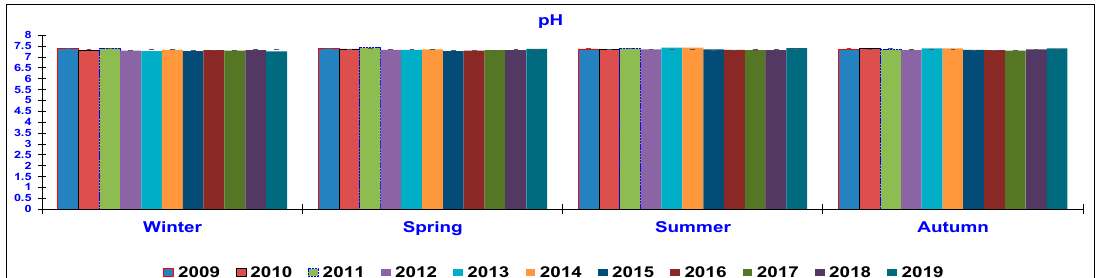
Figure 8. Trend of outlet water Total Phosphorus (TP) (mg/L) (mean ± standard deviation) seasonally determined during the 10 year-study. Different letters (a, b, c) per season show significant differences ( p < 0.05) among the 10 years of sampling.